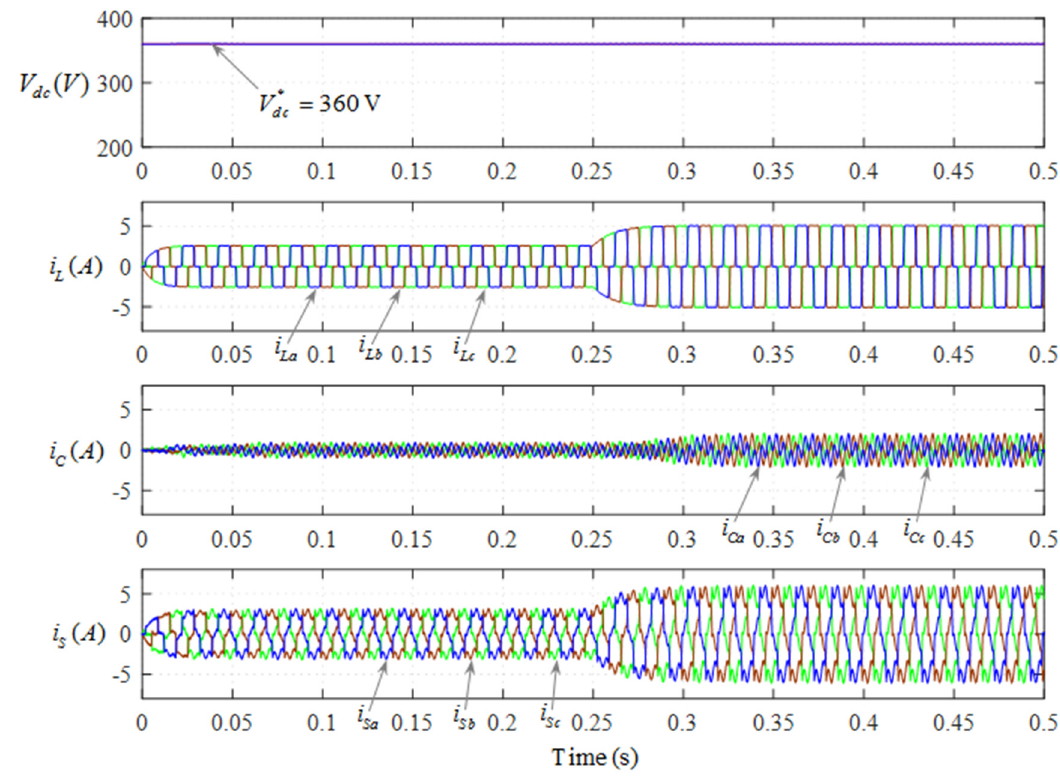
Figure 15. The DC bus voltage, the load current, the compensated current, and the source current.